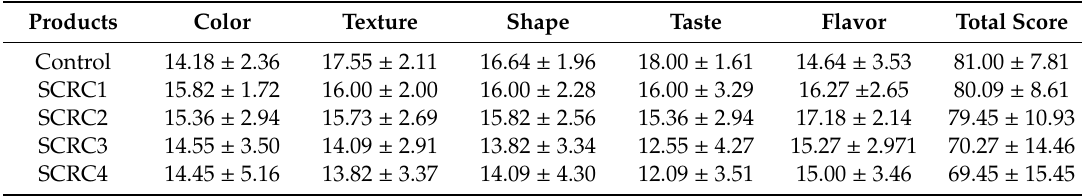
Table 2. E ff ect of SCR addition on the sensory quality of cakes. The five indicators (color, texture, shape, taste, flavor) have the same proportions.